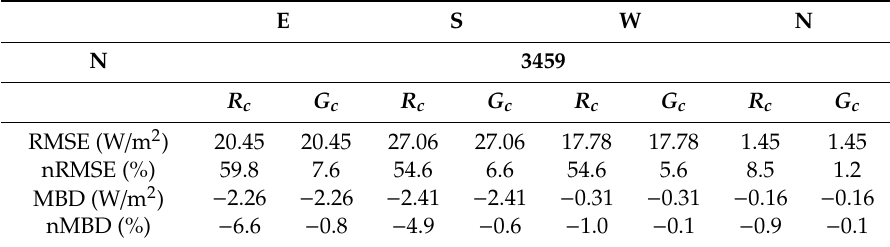
Table 2. Results of the impact in terms of RMSE and MBD of R c and G c values taking Equation (23) with measured albedos and a fixed value ( ρ = 0.21, hourly-average of the full year 2018). E S W N E S W N N 3459 R c G c R c G c R c G c R c G c RMSE (W/m 2 ) MBD (W/m 2 ) nMBD (%) − 6.6 − 0.6 − 1.0 − 0.1 − 0.9 − 0.1